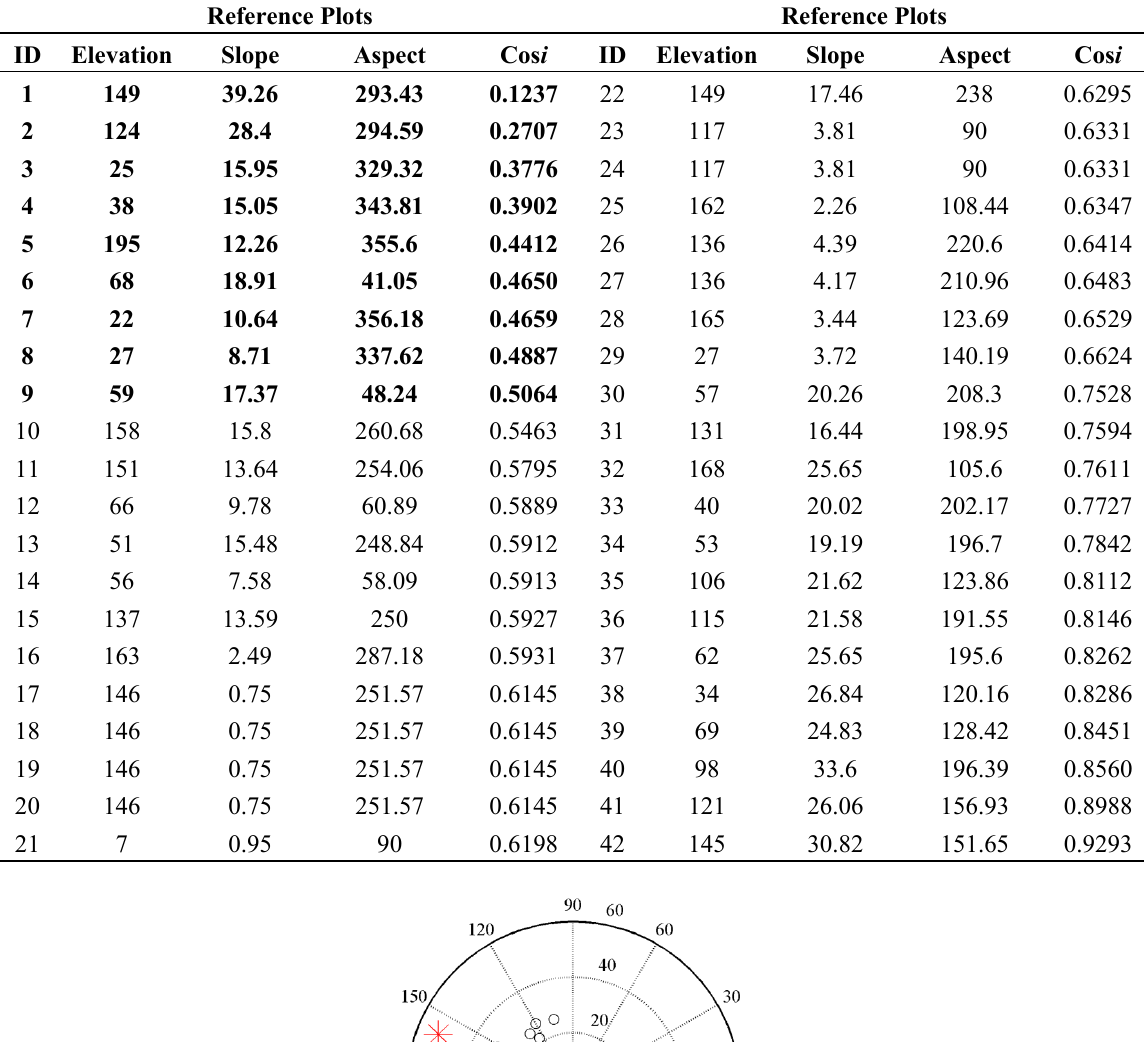
Table 1. Information regarding elevation, slope and aspect of the 42 individual field plots. The variable cosi “ i ” is the angle between the direction of the sun and the local surface normal. The 42 reference plots are split into two groups: (1) reference plots with high cosi (e.g., cosi > 0.51) in black, and (2) reference plots with low cosi (e.g., cosi ≤ 0.51) in bold. The latter reference plots represent non-favorable observations conditions (orientation of the surface) and will therefore be analyzed separately.